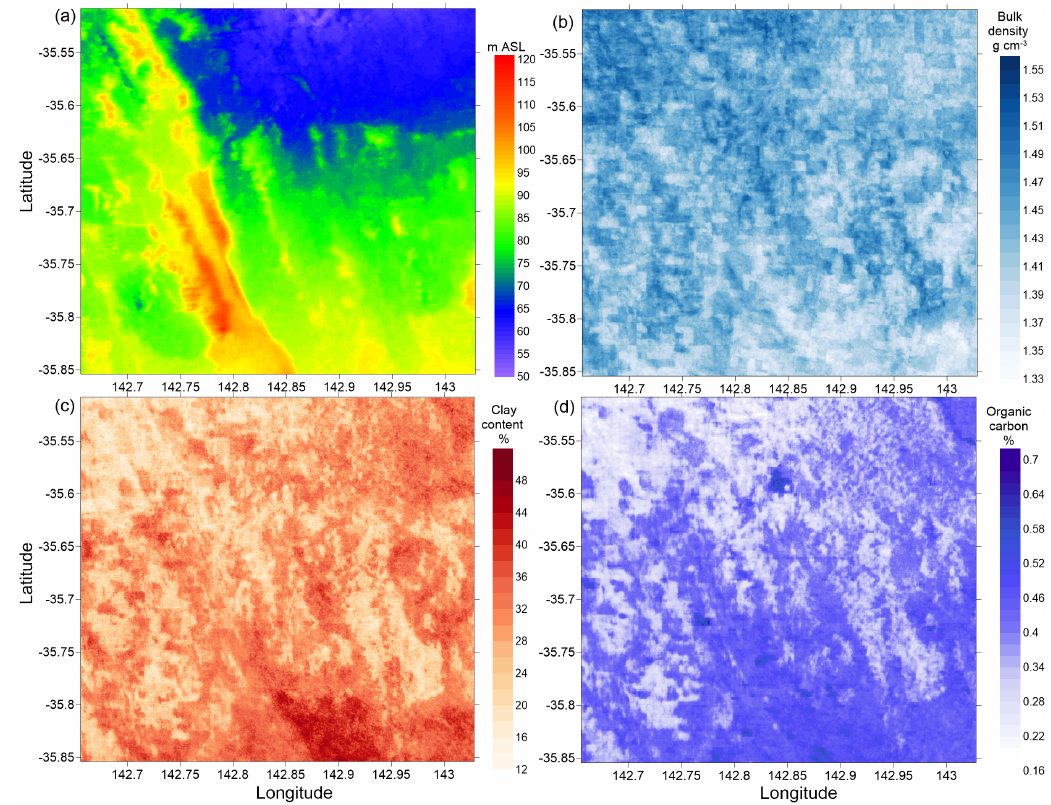
Figure 3. Field survey area DEM (a) , depth-weighted 0–30cm bulk density (b) , depth-weighted 0–30cm clay content (c) and depth-weighted 0–30cm organic matter content (d) .